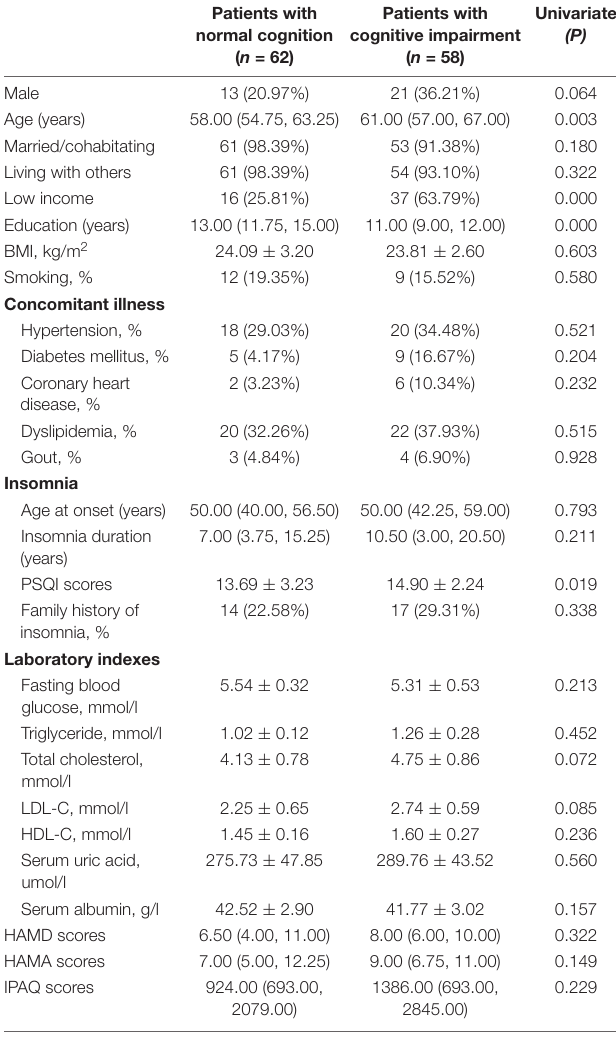
TABLE 1 | Patient characteristics in normal cognition and cognitive impairment groups.